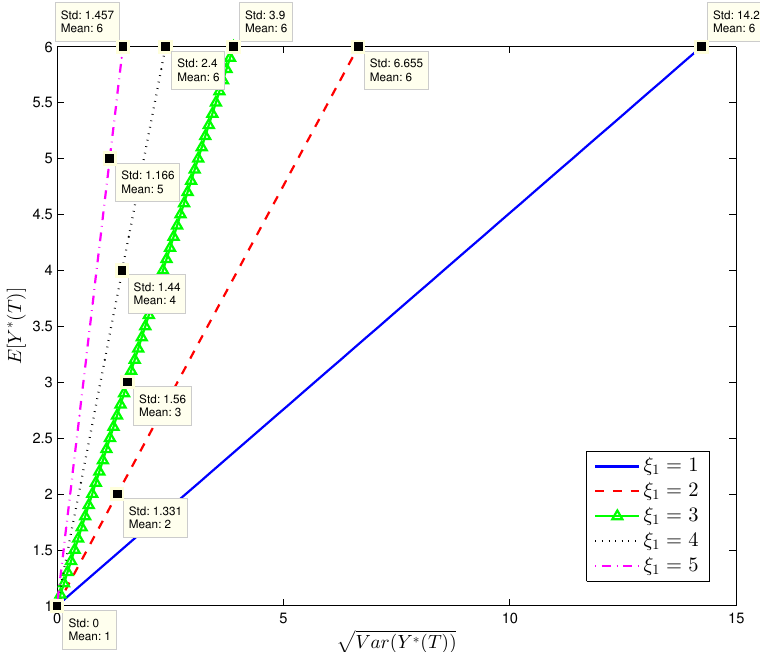
Figure 2. The efficient frontier in the incomplete market with different ξ 1 (In this figure, the values of (cid:112) V ar ( Y ∗ ( T )) corresponding to E [ Y ∗ ( T )] = i are reported for ξ 1 = i , i = 1,2,3,4,5, and the values of to E [ Y ∗ ( T )] = 6 are reported for ξ 1 = 1,2,3,4,5)